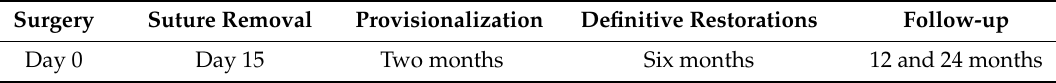
Table 1. Follow-up visits were planned to take place at two months (provisionalization), 6 months (definitive restoration), 12, and 24 months after implant